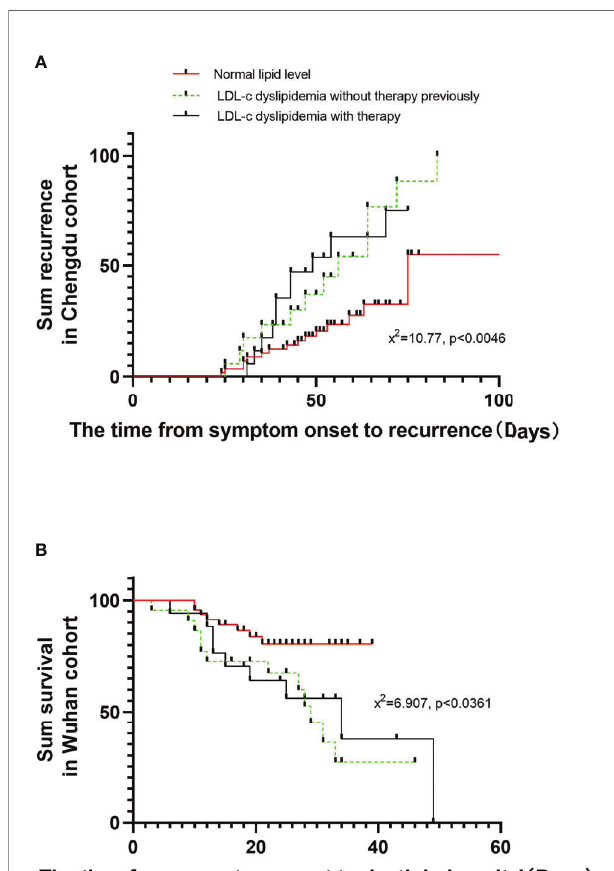
FIGURE 2 | Comparison of the time-dependent risk of reaching to the recurrence after discharge or in-hospital death. The time-dependent risk of reaching to the recurrence after discharge in COVID-19 patients with dyslipidemia or lipid-lowering therapy compared with the control in the Chengdu cohort (A) . (B) shows the time-dependent risk of reaching to the in- hospital death in COVID-19 patients with dyslipidemia or lipid-lowering therapy compared with the control in the Wuhan cohort. Kaplan – Meier analysis was used to estimate and plot survival endpoints among subgroups, with the log-rank test being